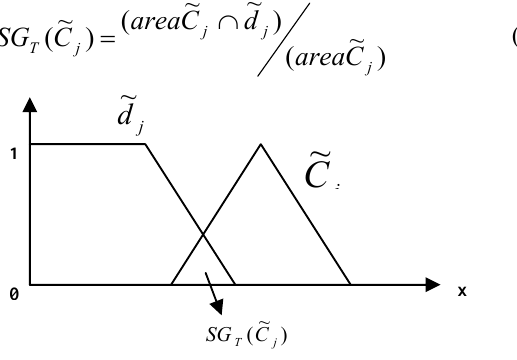
Fig. 5. The possibility measure ~ d . date j The area of intersection measures the portion of that is completed by the due date Fig. 6. The satisfaction grade of a fuzzy completion is defined as follow. 36 time of job j